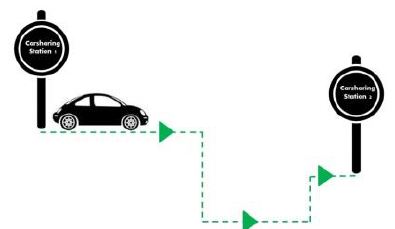
Figure 2. Carsharing station-based one-way (Source: Authors) And the last one known as free-floating one-way, the vehicles are freely parked in public spaces within the operating area (the area serviced by the sharing company), and the journey can begin and end at any point in this area. (Figure 3) (Ferrero et al., 2018).